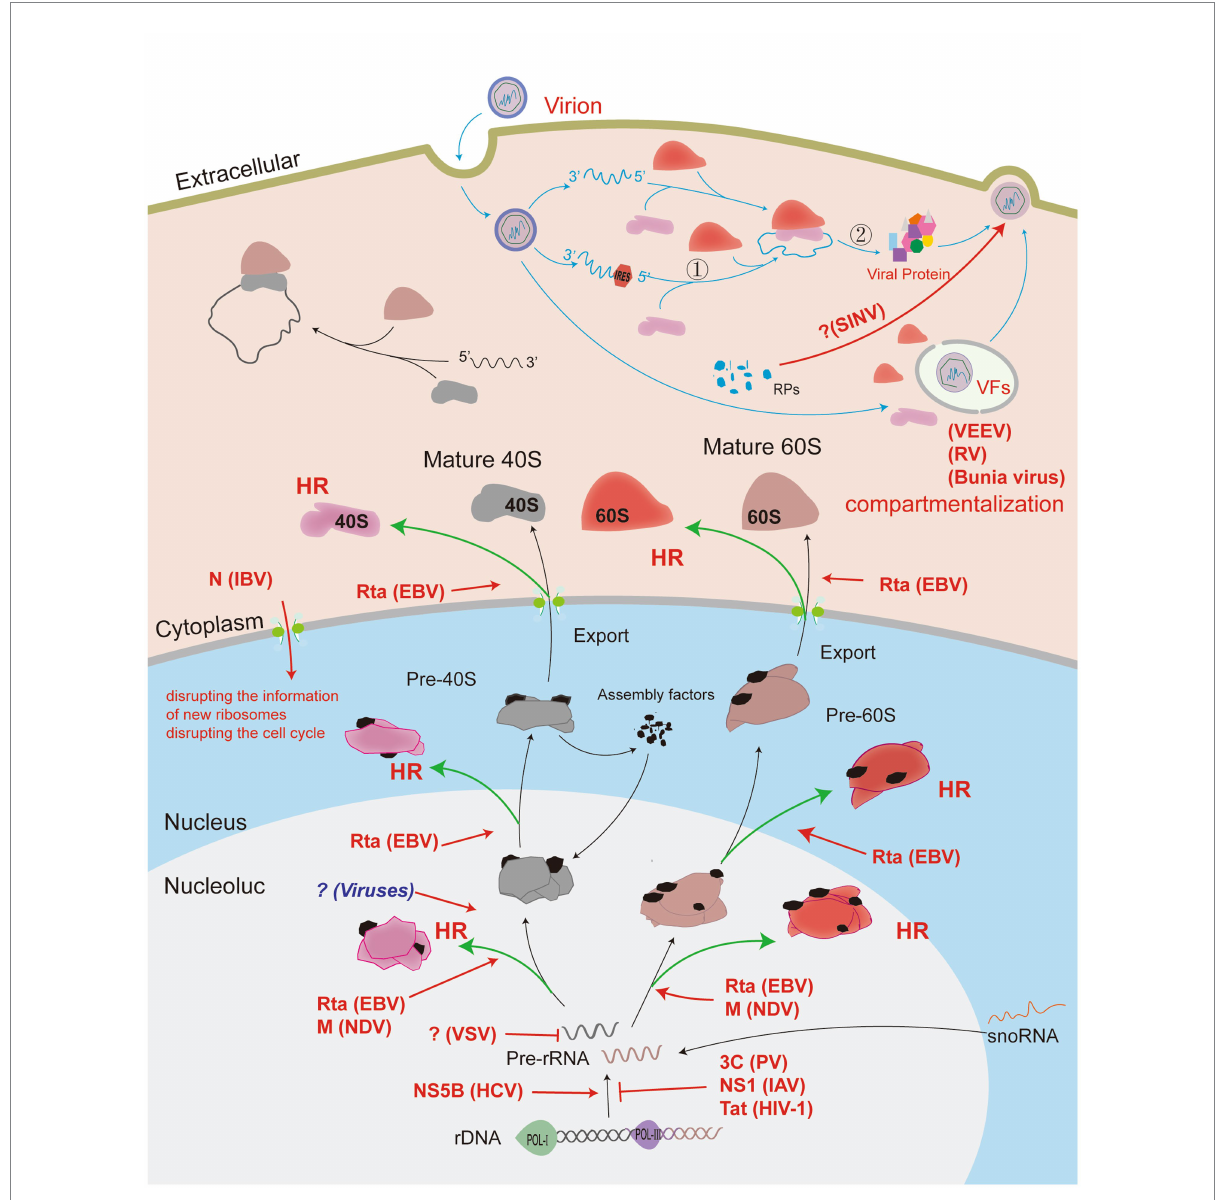
FIGURE 2 Viruses manipulate ribosomes to complete the translation of viral proteins. Viruses invading host cells can manipulate ribosomes to initiate the translation of viral proteins by modulating their own genome structure. The viral genome can also regulate the distribution of host ribosomal compartments or manipulate host ribosomal components to assemble viral particles that facilitate viral protein translation. Ribosome biogenesis begins in the nucleolus, and RNA virus infection causes nucleolus stress, with viral proteins acting on the different functional regions of the nucleolus to induce heterogeneous ribosome biosynthesis (HR). The effect of the virus on the host (red arrow); normal host physiological processes (black arrow); the process of virus proliferation in the cell (blue arrow); the virus-mediated production of heterogeneous ribosomes (green arrow). Process ① represents the recruitment of ribosomes by viruses using a cap-independent structure. Process ② indicates the translation process wherein viruses can use the specific structure of their own mRNA to reinitiate downstream viral